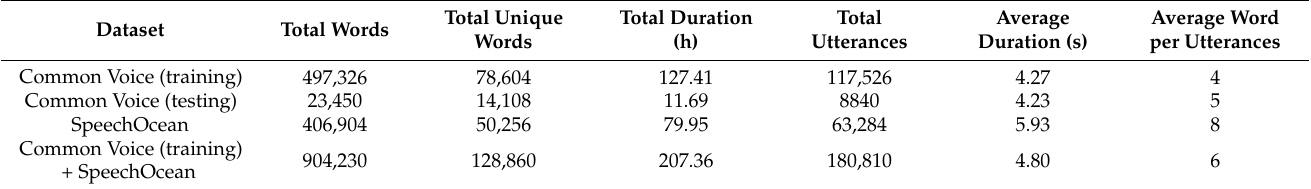
Table 2. Contains the specifics of the Common Voice and SpeechOcean datasets. The ‘training’ set trains the ASR model, while the ‘testing’ set tests its